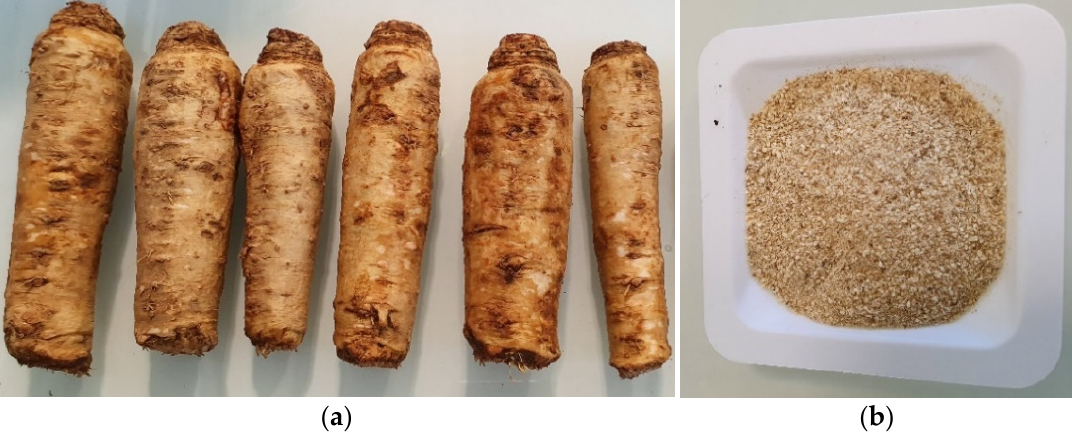
Figure 2. ( a ) Washed forced chicory roots; ( b ) Ground forced chicory roots .